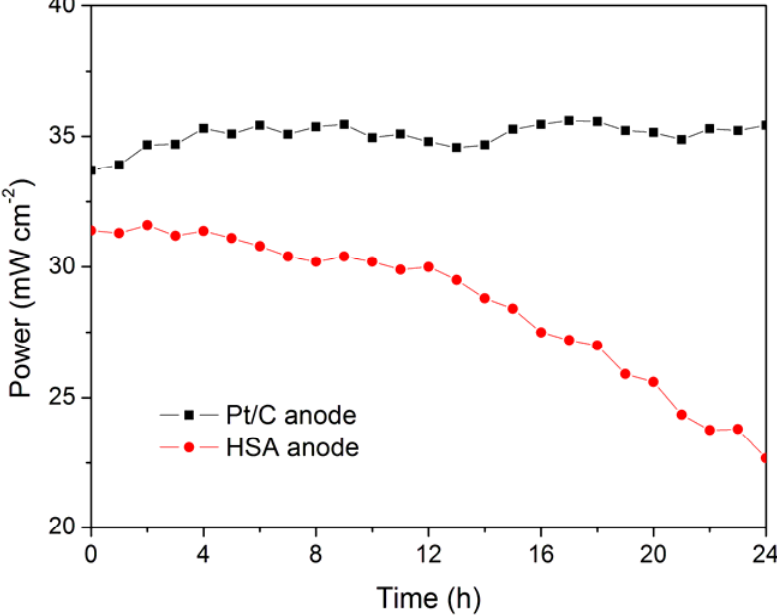
Figure 3. Working stabilities of the HSA anode membrane electrode assembly (MEA) in comparison with Pt/C MEA at a constant current load of 40 mA/cm 2 (operating conditions: electrode area 1 cm 2 , pressure P = P = 2 atm; working temperature T H2 O2 wetting temperature T = T = 40 anode cathode